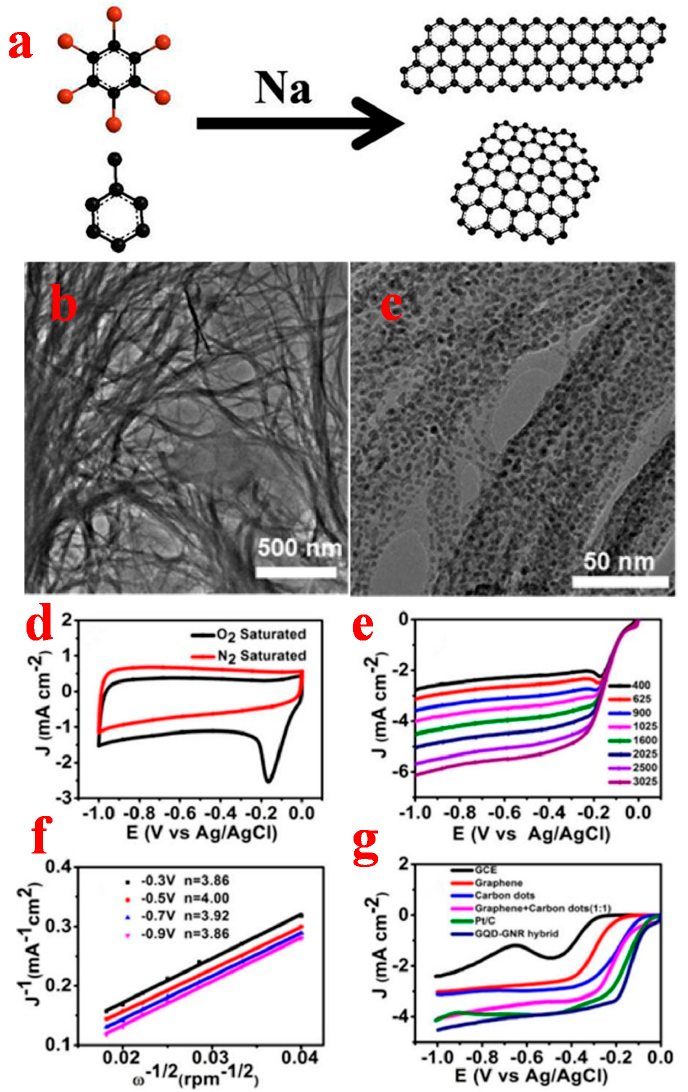
Figure 8. ( a ) Schematic charts for the synthesis of GQD ‐ GNRs. ( b,c ) TEM images of GQD ‐ GNR composites; ( d ) CV curves of GQD ‐ GNR composites in N 2 ‐ and O 2 ‐ saturated 0.1 M KOH solution; ( e ) LSV curves for GQD ‐ GNR composites with different rotating speeds; ( f ) K ‐ L plots of GQD ‐ GNR composites from LSVs; ( g ) LSV curves of different electrocatalysts in O 2 ‐ saturated 0.1 M KOH solution. Reprinted with permission from [117]. Copyright 2015, American Chemical Society.